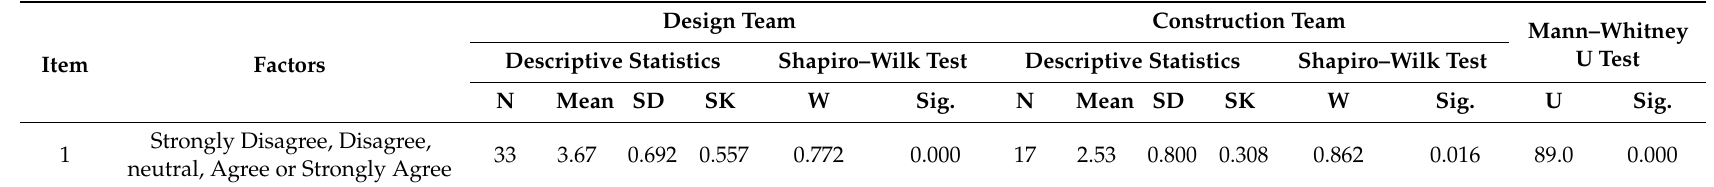
Table 2. Comment on the statement of statutory control and monitoring mechanism of the external stone cladding system are relatively loose compared with other external façade systems (Comparison between ‘Design Team’ and ‘Construction Team’, n = 50).